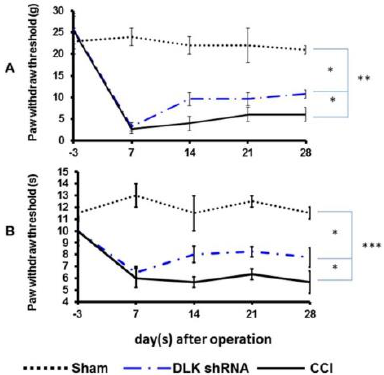
Figure 5. Representative images of mechanical allodynia and thermal hyperalgesia treated by DLK shRNA administrated 24 h after CCI. ( A ) Plot of mechanical allodynia in different treatment groups in gm related to different time frame. ( B ) Plot of thermal hyperalgesia in different treatment groups related to different time frame. * p < 0.05; ** p < 0.01; *** p < 0.001.